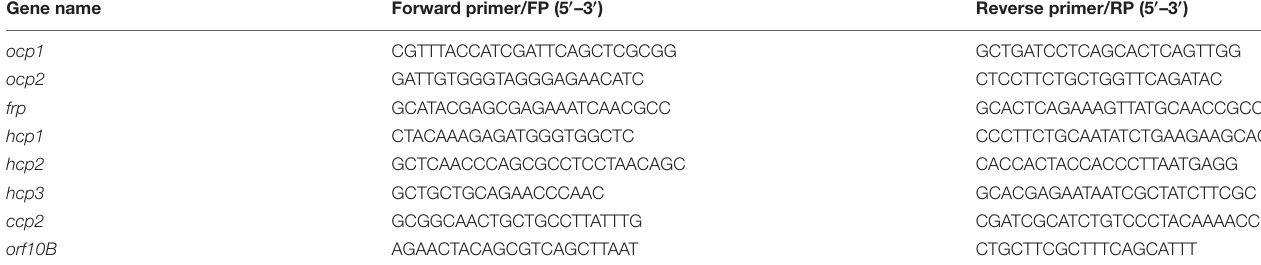
TABLE 1 | Primers for quantitative real-time PCR (qPCR).